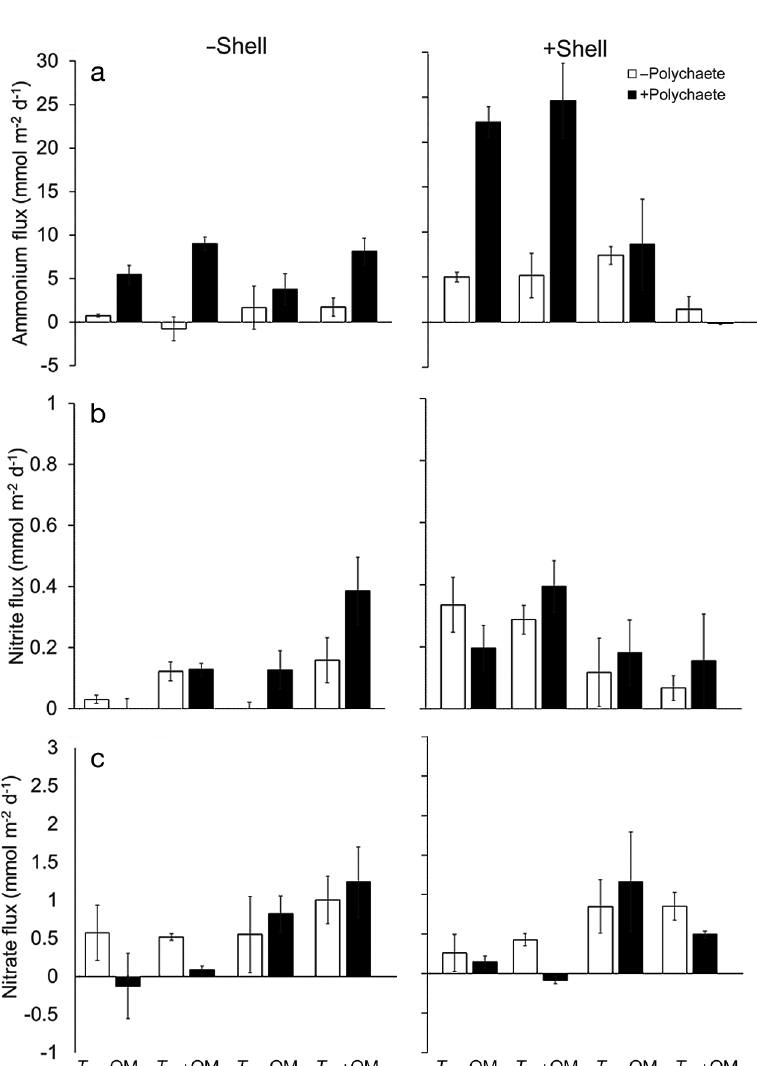
Fig.6.Effectofshells(−Shell,leftcolumn;+Shell,rightcolumn)onnitrogenfluxes insedimentsatdifferentorganicmatterloads(−OM/+OM)andat2differentsam- pling times ( T 1 : after 1 wk; T 2 : after 3 wk) in the presence and absence of poly- chaetes (−Polychaete/+Polychaete). (a) Ammonium, (b) nitrite and (c)